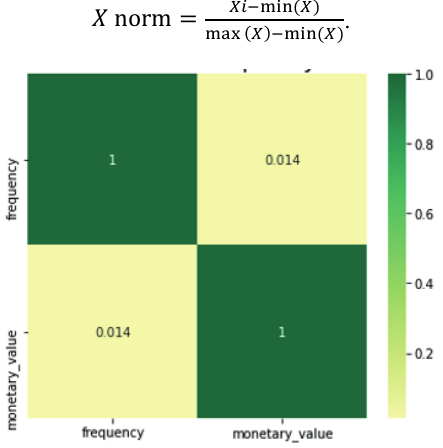
Fig. 5. Actual purchases in holdout period vs. predicted purchase. Fig. 6. Frequency & Monterey correlation